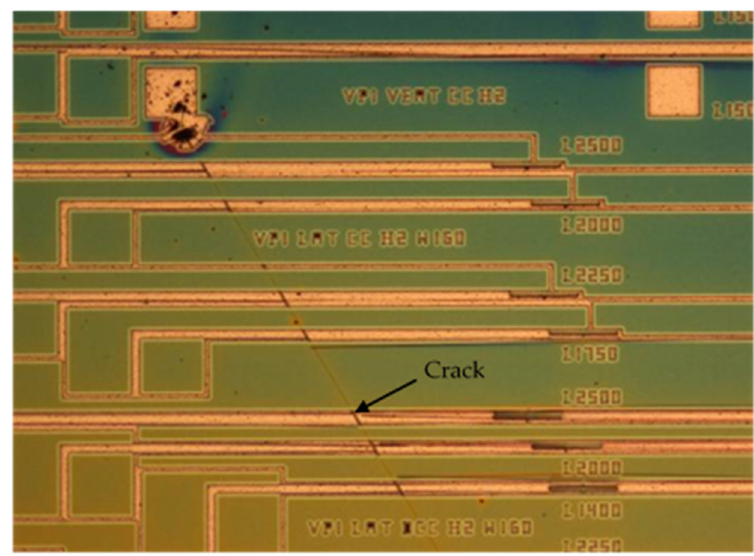
Figure 8. Cracks appearing after SiC micromachining on <111> substrates.